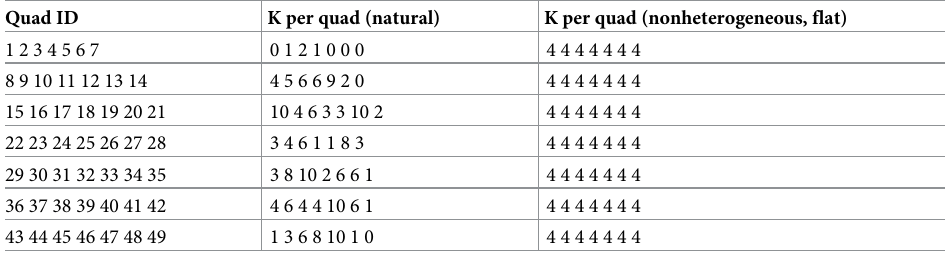
Table 1. Array of quads in Bakersfield with heterogeneous carrying capacity (K) set to reproduce natural differ- ences in kit fox K across the city compared with a “flat” landscape in which each quad has the same